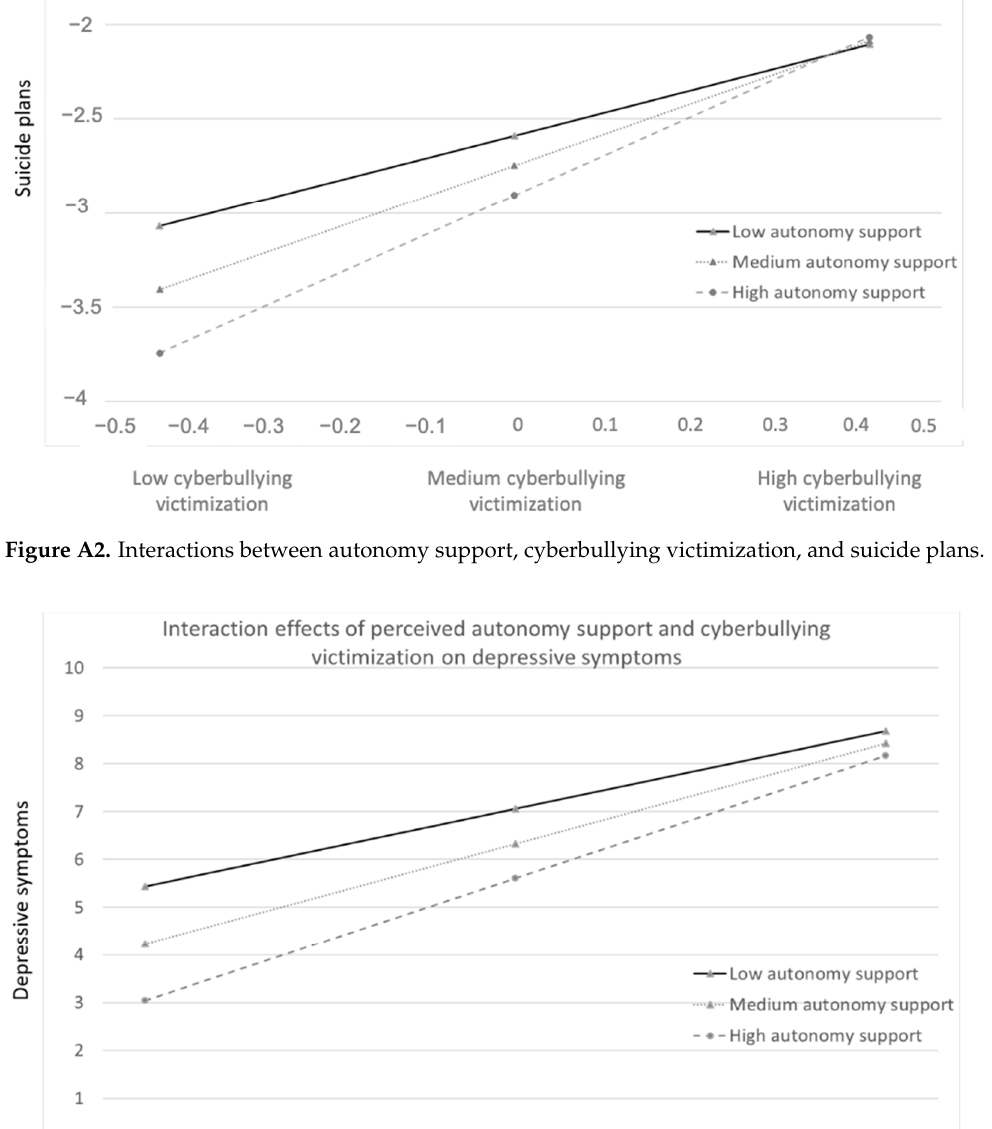
Figure A1. Interactions between autonomy support, traditional bullying victimization, and de- pressive symptoms.